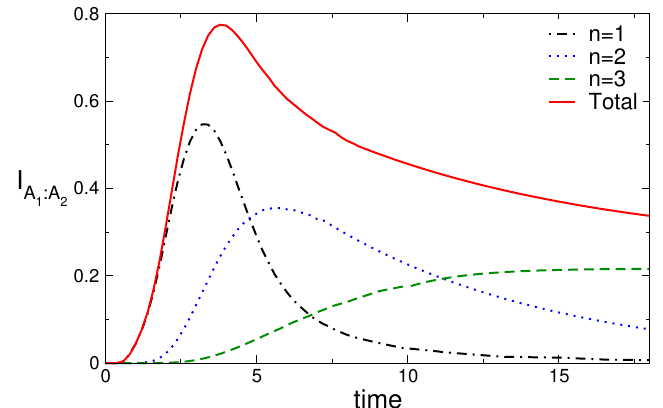
between two disjoint A 1 : A 2